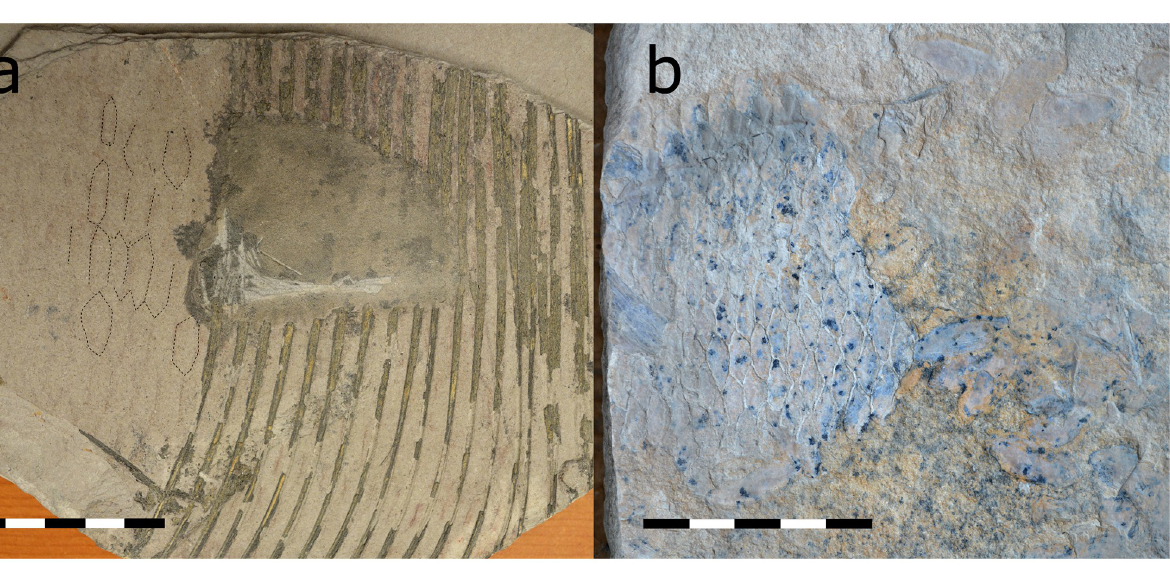
3.3.2 Scales and color. Scales are rhombic in shape and preserved as shadow imprints in three T . formosa specimens from Vallecillo (Fig 7A). One specimen interpreted as